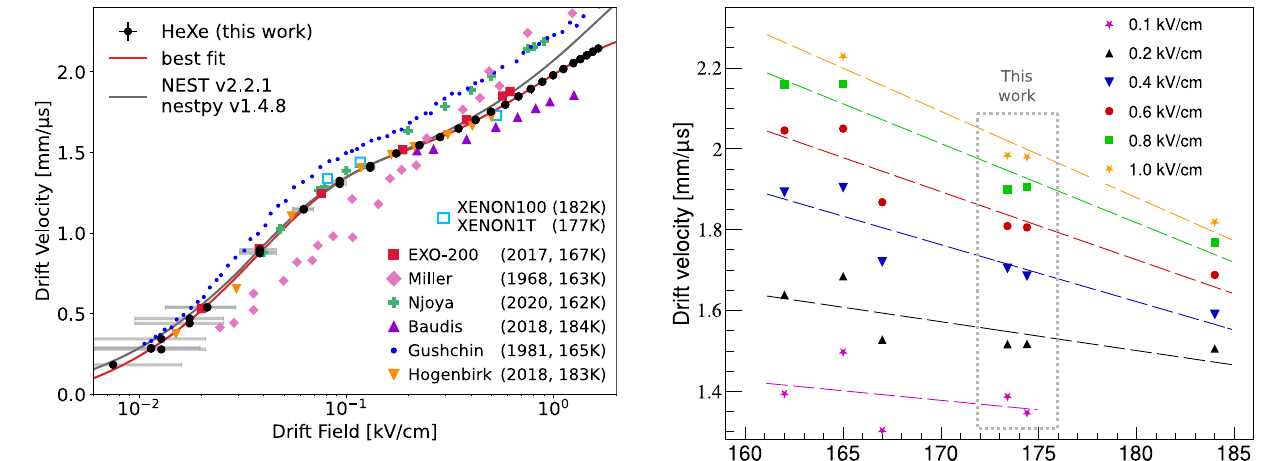
Fig. 20 Drift velocity of electrons in LXe from alpha-particle interac- tions as measured using the HeXe setup at T = 174K as a function of applied drift field. Horizontal gray bars indicate the central 68% quan- tile range of the field values throughout the drift volume. For better visibility the data points from 83m Kr are not shown but are provided online [32]